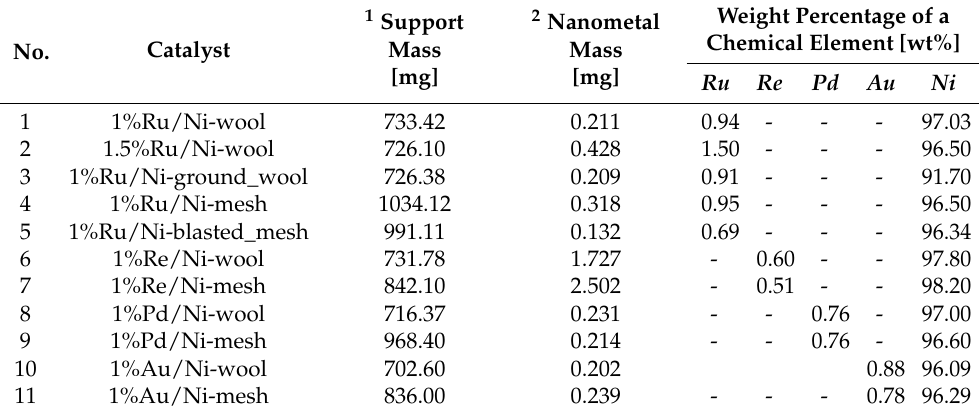
Table 3. Mass of support and nanometals, and EDXRF analysis of Ru, Re, Pd, Au, and Ni for the tested catalytic